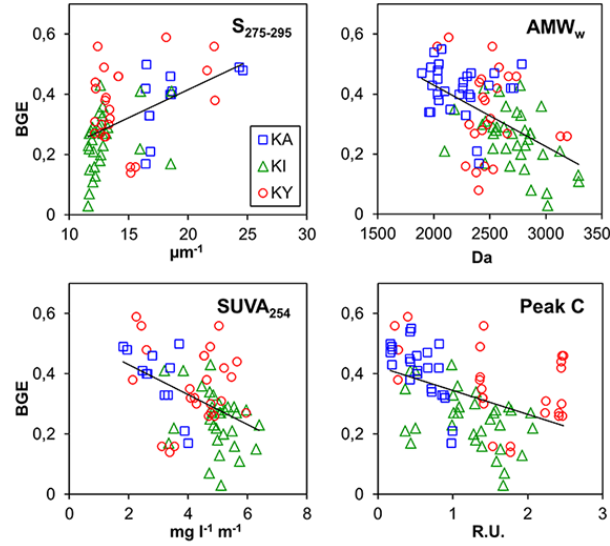
Fig. 8. Relationships between different DOM variables and BGE. AMW w : apparent weight-averaged molecular weight, S 275 − 295 : slope coefficient between wavelengths 275 and 295nm, SUVA 254 : carbon specific absorbance at 254nm, and peak C: humic-like fluorescence peak C. Linear regression for the best-fit line describing relationships between slope BGE and AMWw: y = − 2 . 1 × 10 − 4 ×+ 0.84, R 2 = 0 . 27, F = 33 . 41; S 275 − 295 : y = 0 . 018 ×+ 0.43, R 2 = 0 . 23, F = 20 . 59; SUVA 254 : y = − 0 . 050 ×+ 0.53, R 2 = 0 . 19, F = 17 . 06; and Peak C: y = − 0 . 079 ×+ 0.42, < 0.001. Subsets indicate different estuaries: KA: Karjaanjoki, KI: Kiiminkijoki and KY: Kyrönjoki. Data are pooled from all